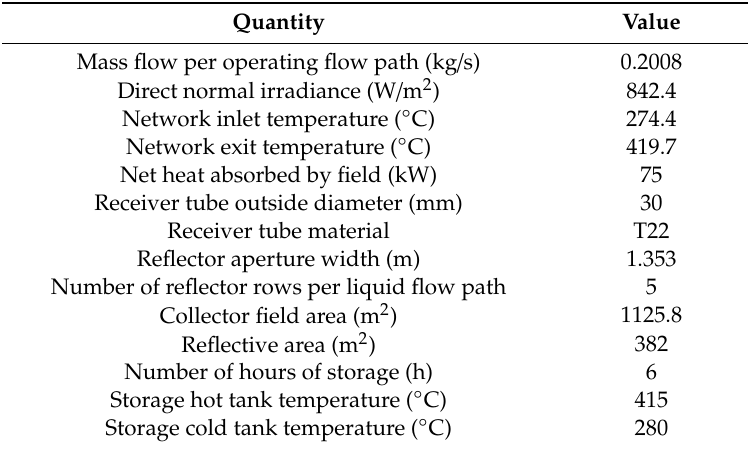
Table 2. Solar field characteristics.